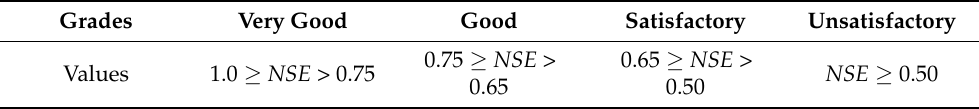
Table 3. Evaluation criteria of NSE